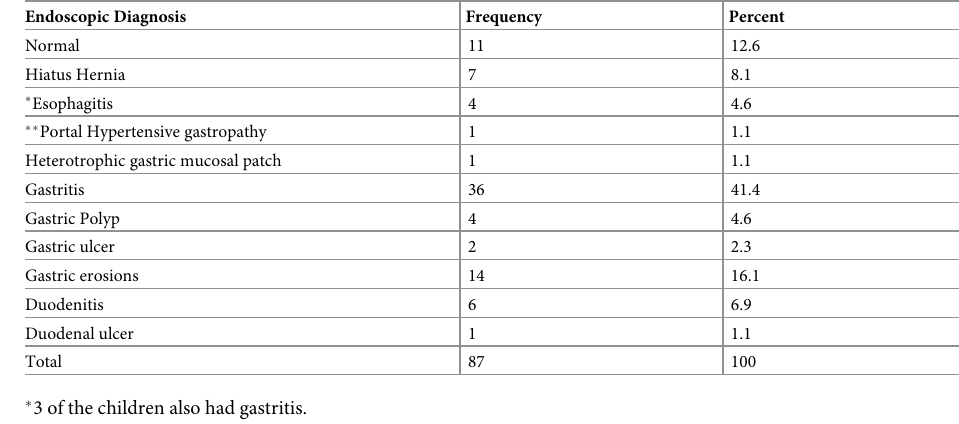
Table 2. The endoscopic diagnosis in the study participants with